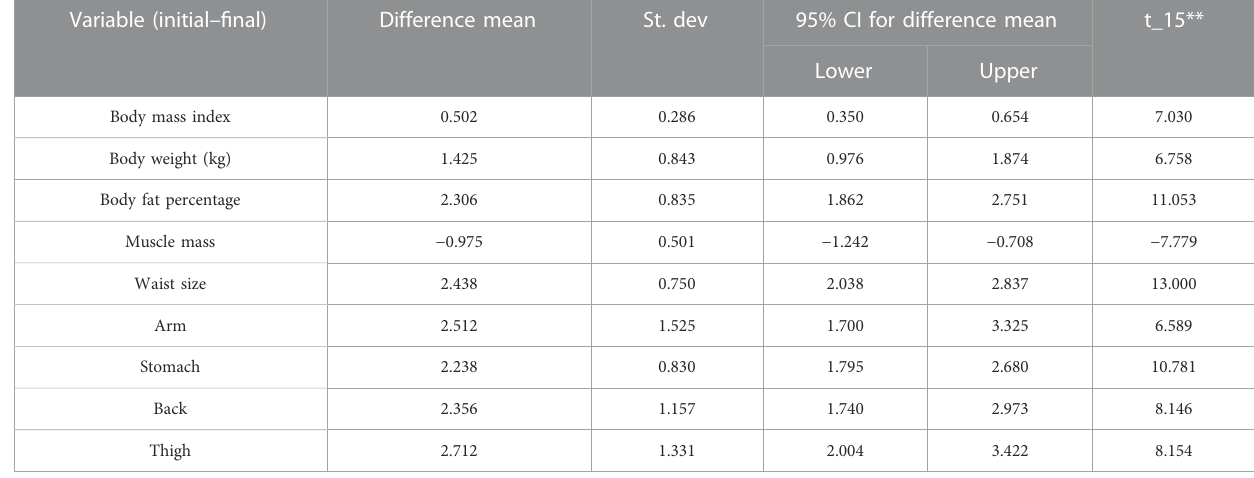
TABLE 3 Results of the T-test for paired samples: The differences of the fi nal state scores compared to the initial state scores. Variable (initial – fi nal)